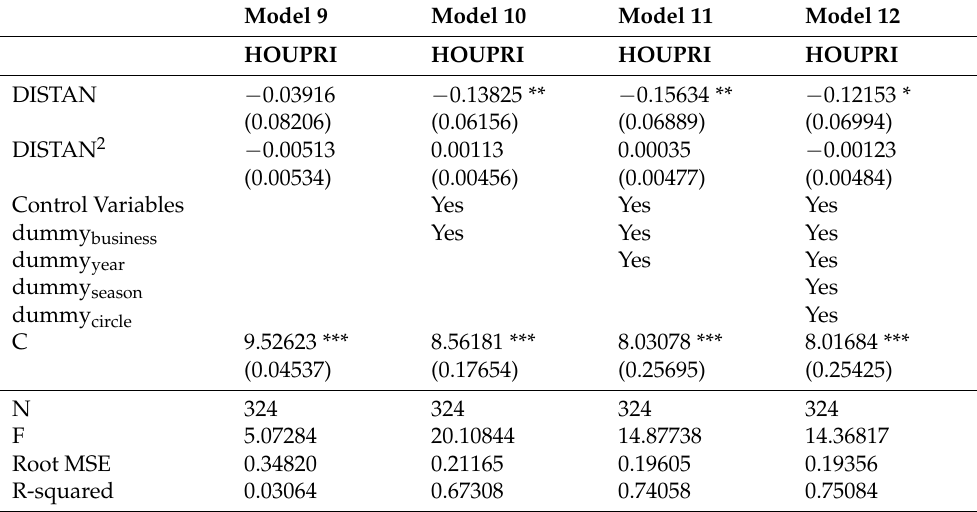
Table 4. Therelationshipbetweenthedistanceandhousingpricesafterthereleaseoftheassessmentreport.